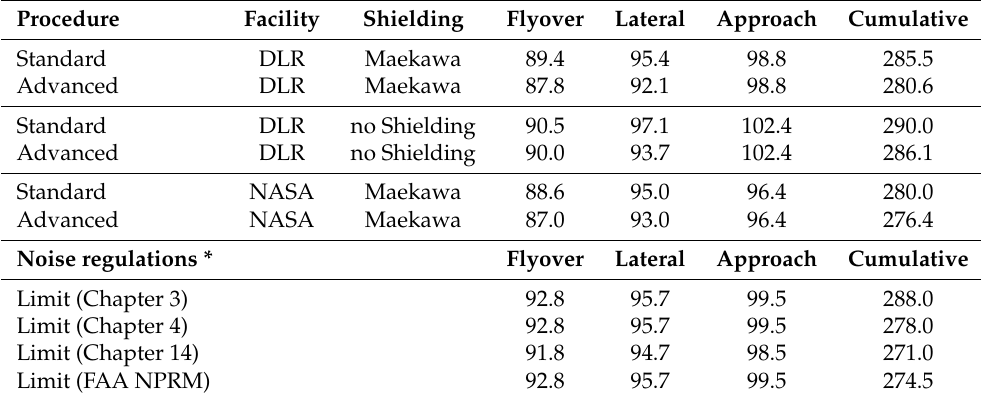
Table 3. Simulated certification levels at individual measurement points (flyover, lateral and ap- proach) and cumulative level for NASA 55t STCA. Limits of individual measurement points and cumulative from ICAO Annex 16 and FAA NPRM for Noise Certification of Supersonic